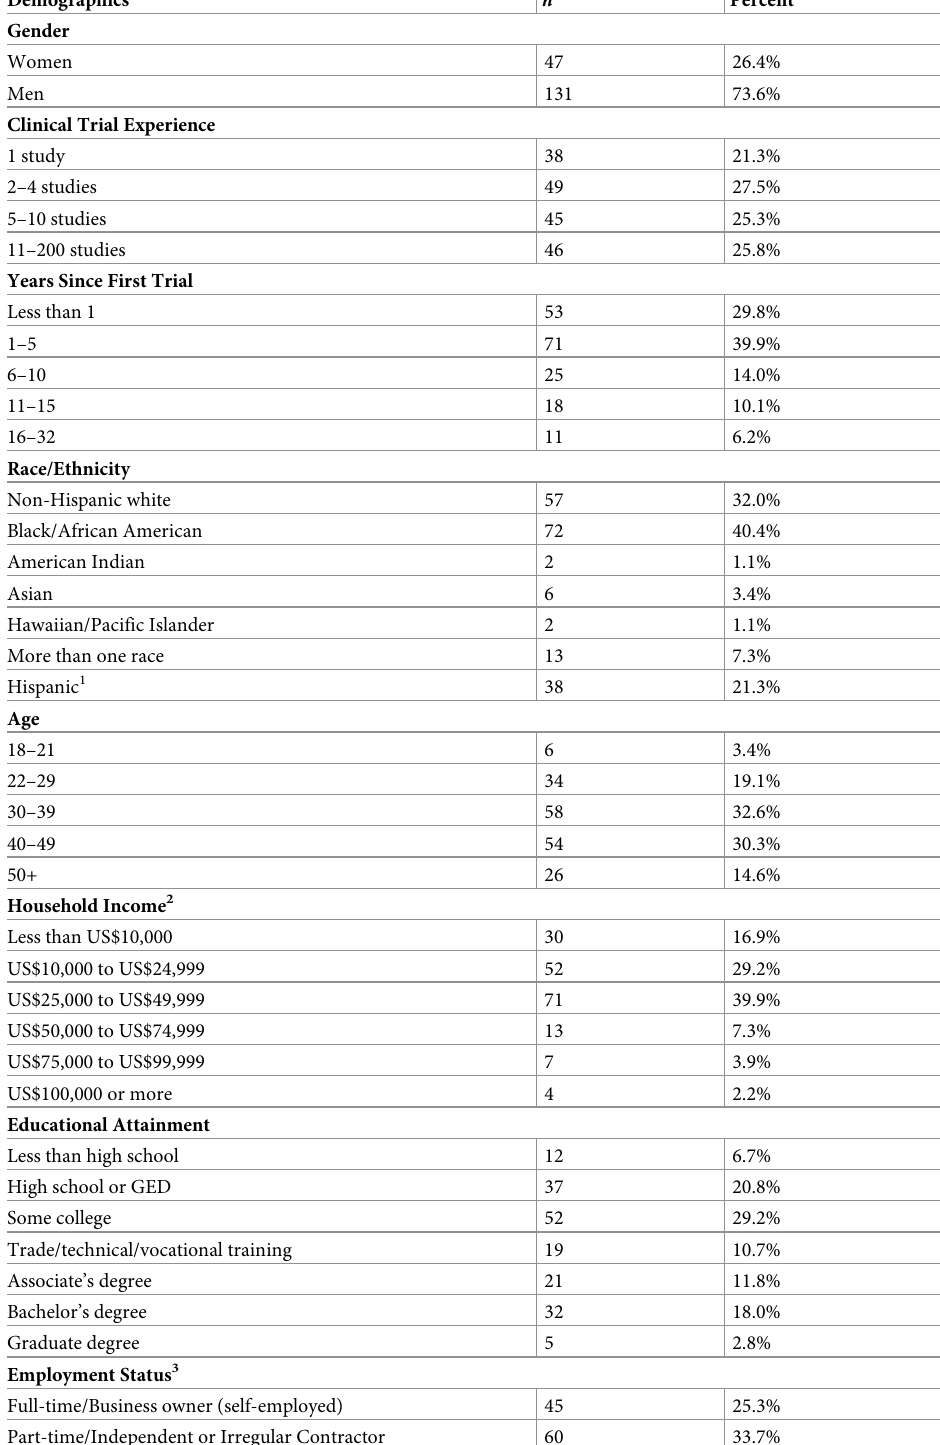
Table 1. Demographics of study participants ( N =